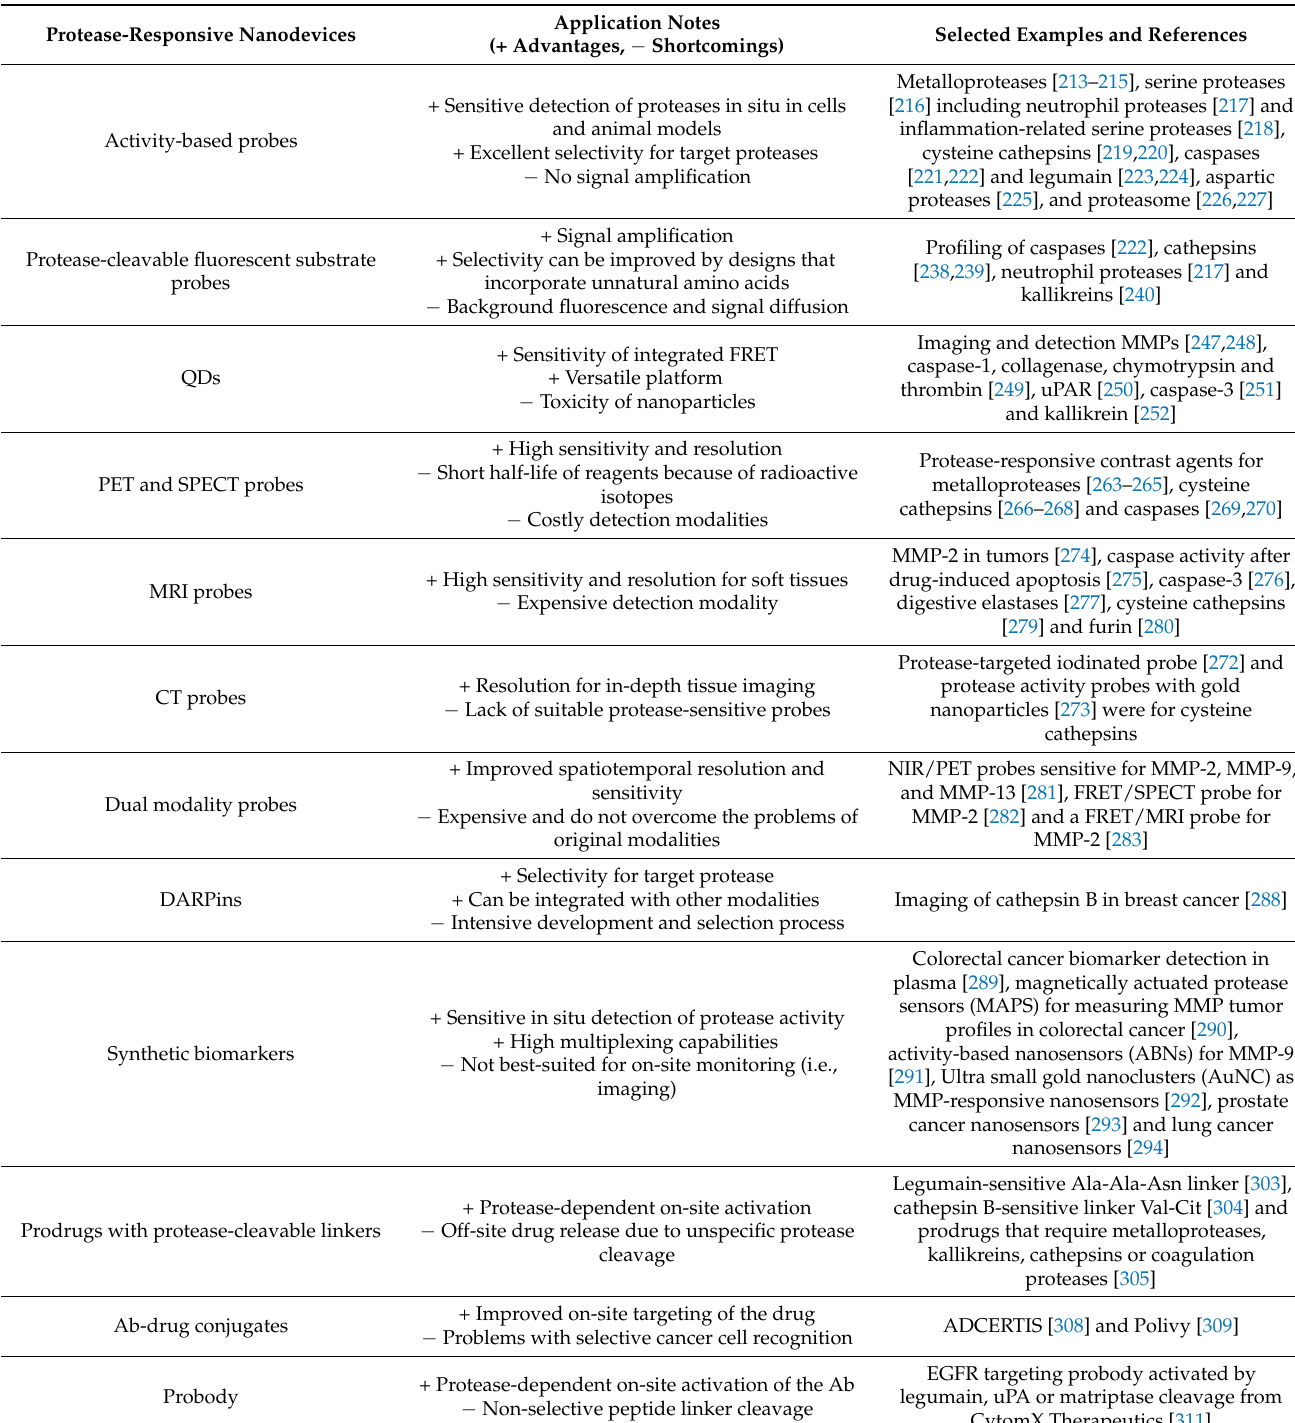
Table 2. Protease-responsive nanodevices for diagnostic and therapeutic purposes, application notes (describing advantages and shortcomings of the indicated modalities) and selected examples of